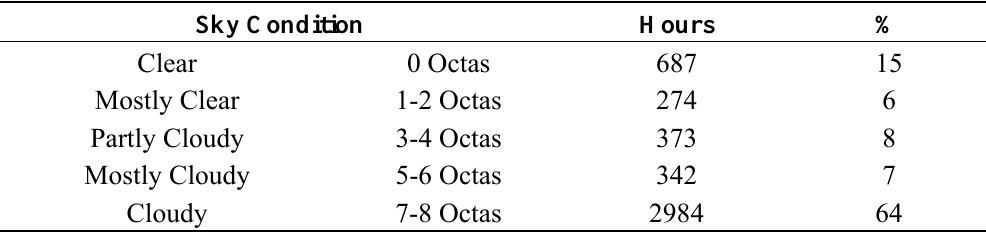
Table 2. Frequency of occurrences of sky conditions for the city of Bogotá. Source: Meteonorm